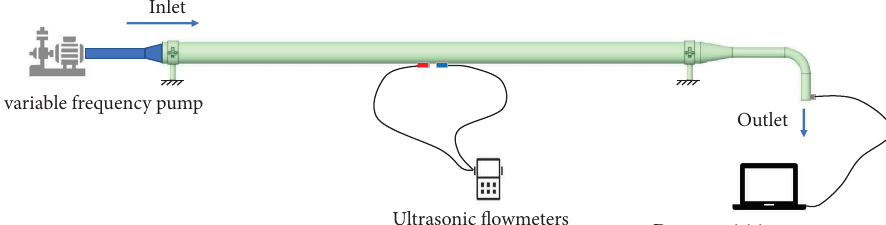
Figure 7: Diagram of the experimental principle.